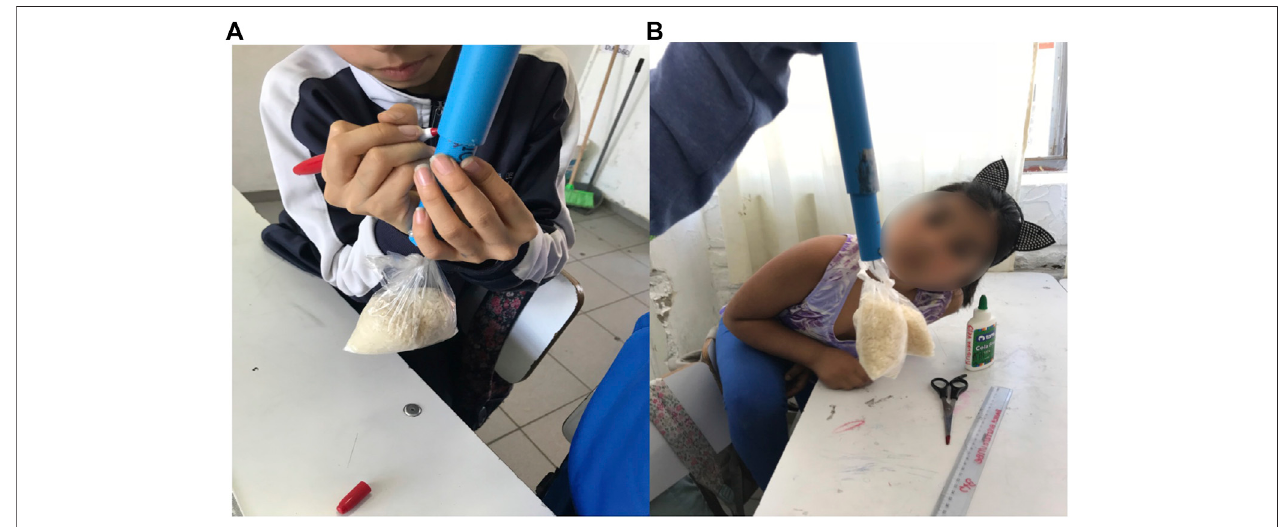
FIGURE 6 | (A) strategic cognitive achievement; (B) conceptual